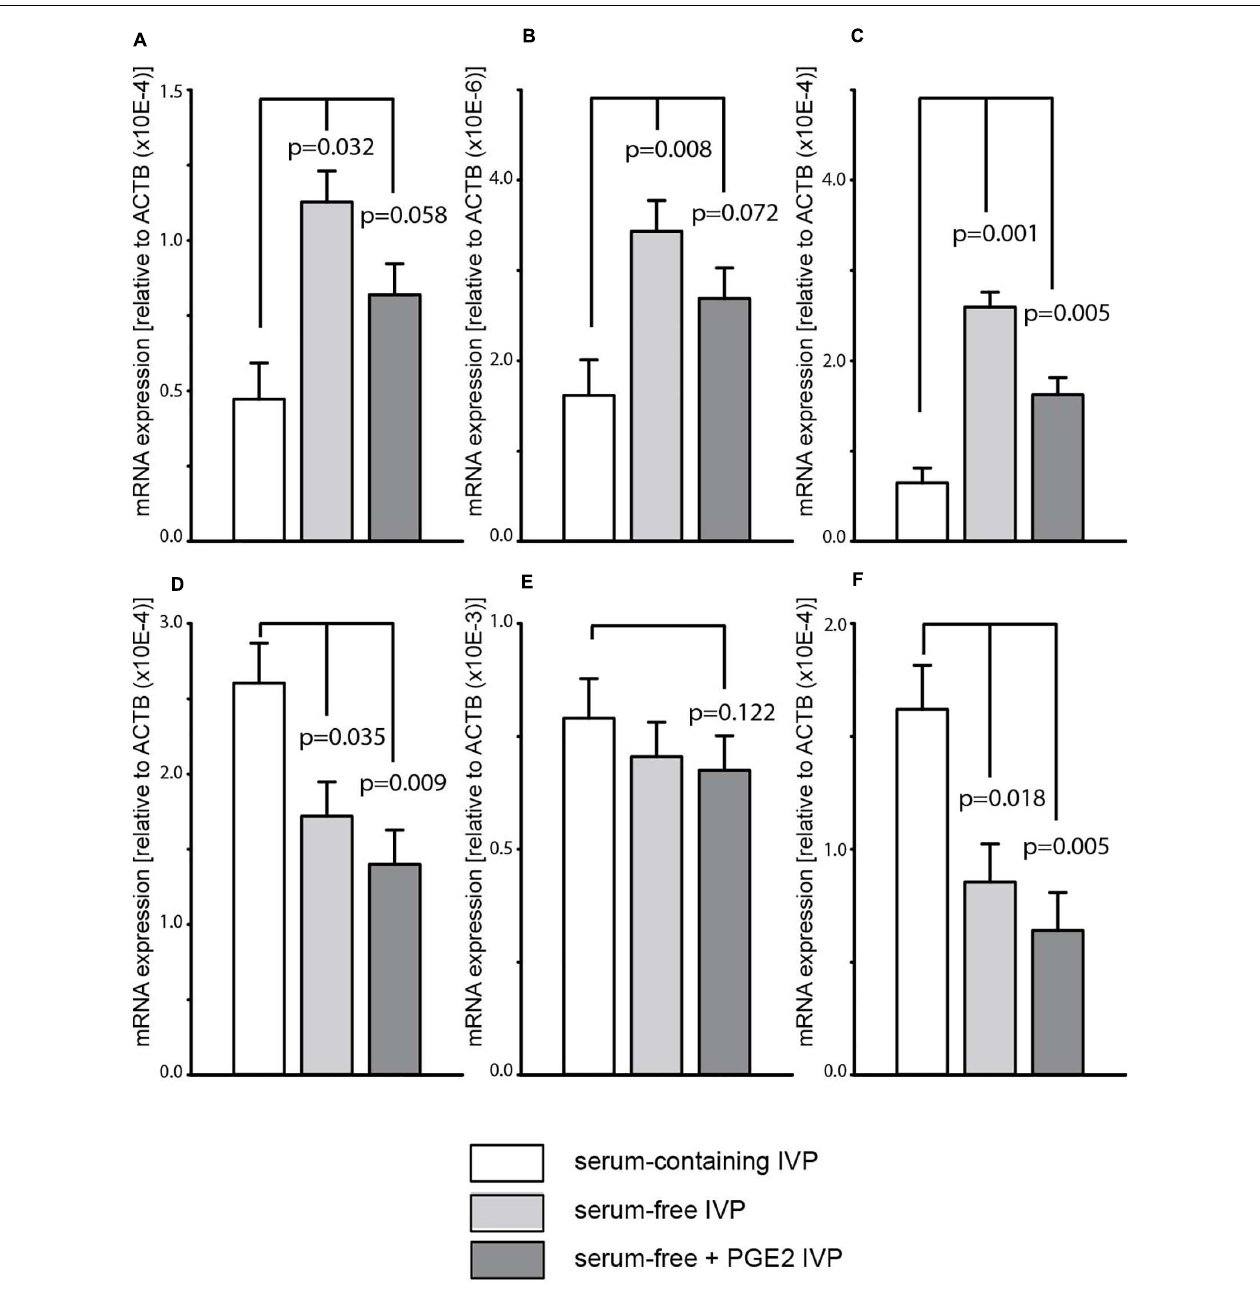
FIGURE 5 | Differences in gene expression between inner cell masses derived from “serum-containing,” “serum-free,” and “serum-free + PGE2” in vitro production (IVP) as determined by quantitative PCR. Two genes are related to the epigenetic regulation pathway: JARID2, Jumonji and AT-Rich Interaction Domain Containing 2 (A) ; DNMT1, DNA (cytosine-5)-methyltransferase 1 (B) . Four genes are related to the apoptosis pathway: MYBBP1A, Myb binding protein 1A (C) ; DDIT3, DNA damage-inducible transcript 3 (D) ; HERPUD1, homocysteine-inducible, ER stress-inducible, ubiquitin-like domain member 1 (E) ; GADD45A, Growth arrest and DNA damage-inducible alpha (F) . Values are represented as LS mean ± SE of each transcript corrected with the housekeeping gene